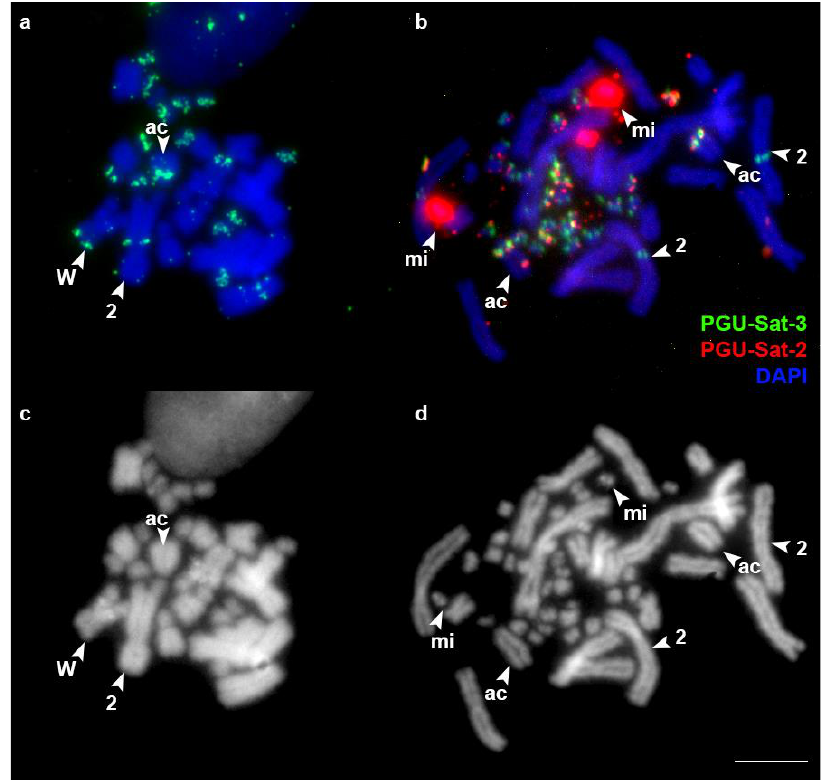
Figure 2. Localization of the satellites PGU-Sat-2 and PGU-Sat-3 in the chromosomes of P. guttatus. mi: the PGU-Sat-2 bearing microchromosome; ac: the acrocentric macrochromosome with both PGU-Sat-2 and PGU-Sat-3 signals; 2: chromosome 2; W: the W chromosome. ( a , b ) Merged images; ( c , d ) DAPI channel. Scale bar: 10 µ